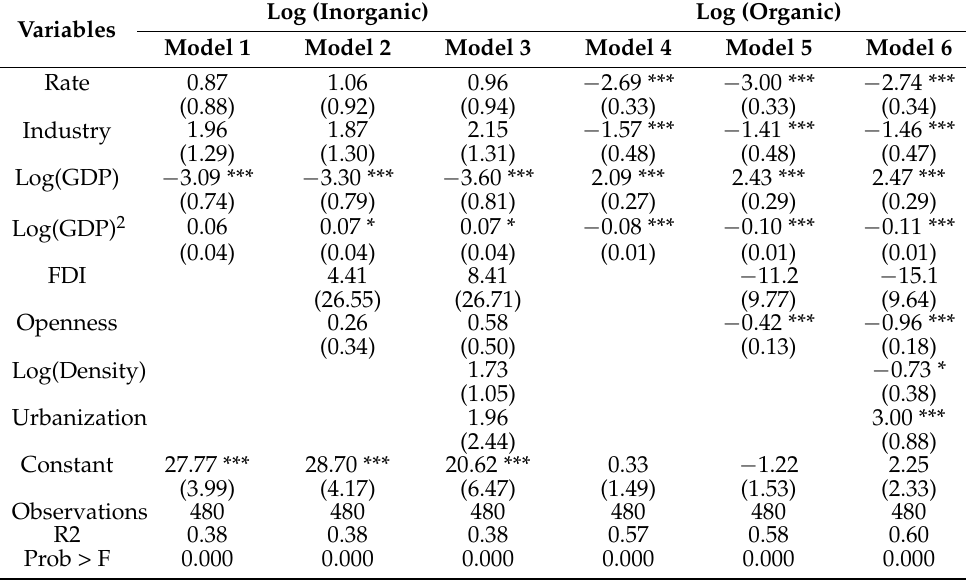
Table 5. The results of panel fixed effect model: Rate as the independent variable. Variables